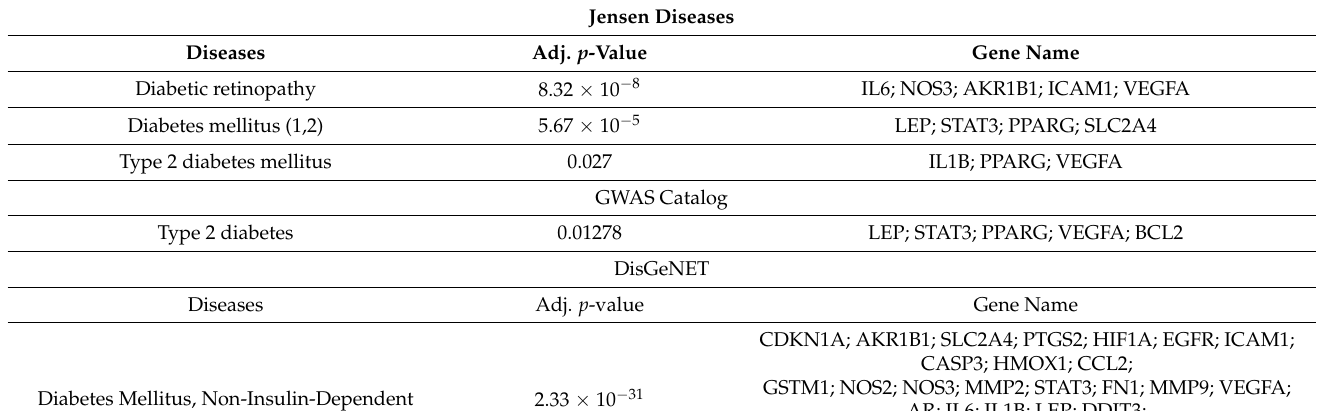
Table 3. Enrichment analysis of 35 shared genes through diverse gene association diseases databases based on Enrichr algorithm for diabetic